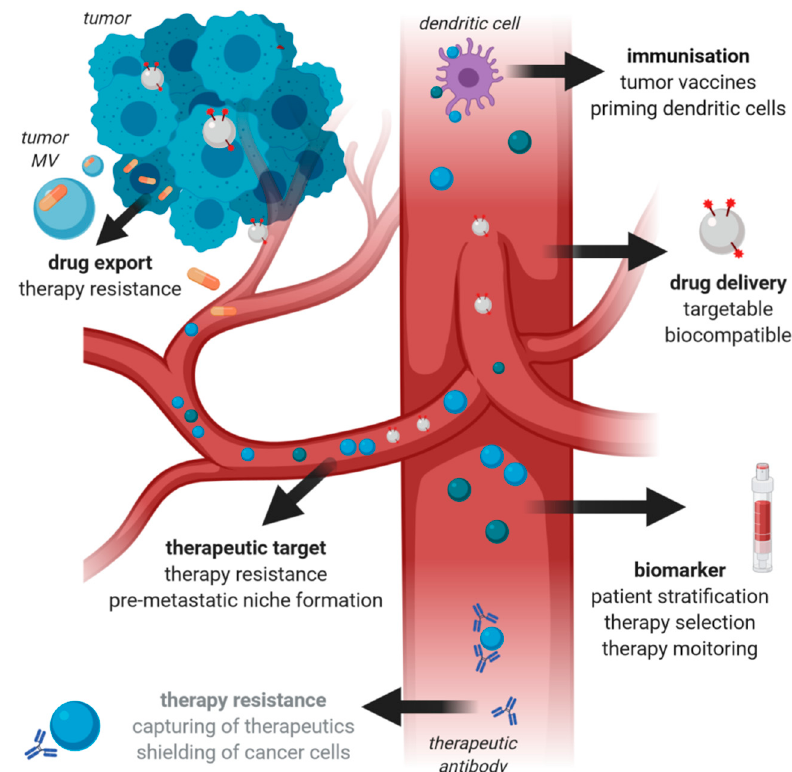
Figure 3. MV in cancer therapy. The figure summarizes the roles of MV in cancer therapy. Once a tumor has gained access to the circulation, circulating tumor MV in blood can be used as biomarkers in liquid biopsies. Moreover, they can mediate therapy resistance by capturing or exporting the administered anti-cancer drugs. Due to their role in therapy resistance and tumor microenvironment crosstalk resulting in pre-metastatic niche formation, they should be regarded as a novel therapeutic target. However, MV can also have a beneficial role in cancer therapy as they represent promising novel drug delivery systems with the benefits of high biocompatibility as well as opportunities for specific targeting and crossing of biological barriers. Vesicular functions, which have only been reported for endosomal-derived small exosomes (Exo) and lack experimental proof for MV, are highlighted in grey.